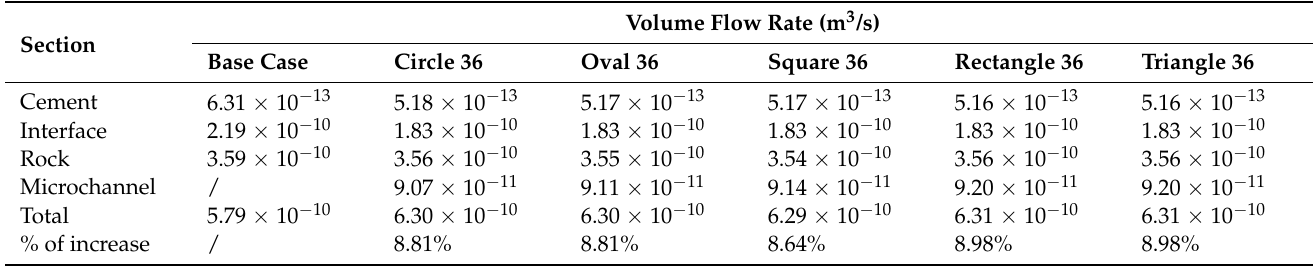
Table 7. Volume flow rate through cement–rock sample: comparison of the base case (no